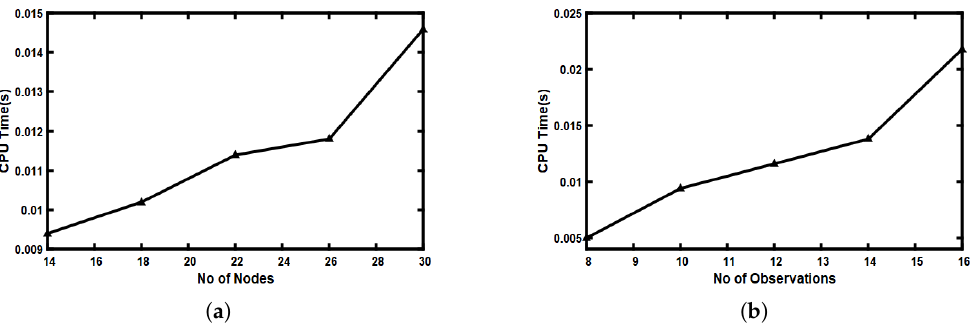
Figure 5. Effects of varying number of nodes and number of observations on CPU time of AV algorithm: ( a ) varying number of nodes; ( b ) varying number of observations.